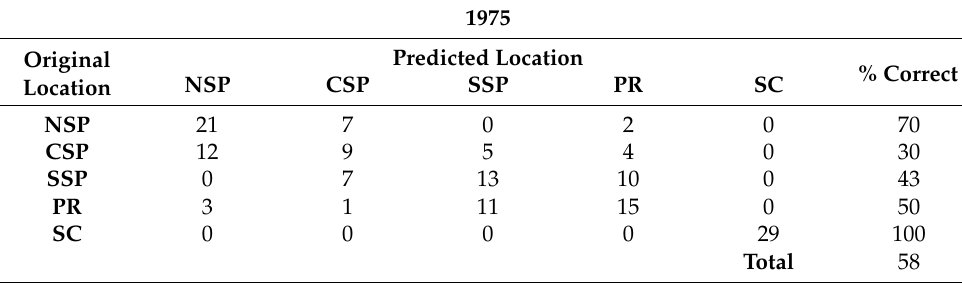
Figure 3. Canonical analysis of principal coordinates (CAP) plots from otoliths chemical composition analysis of Isopisthus parvipinnis collected in the five sampling locations in the South Brazil Bight in 1975 and 2018/2019. Legend: North of São Paulo (NSP), Center of São Paulo (CSP), South of São Paulo (SSP), Paraná (PR), and Santa Catarina (SC). Table 4. Jackknifed cross-validation reclassification matrices obtained from otolith’s elemental composition of Isopisthus parvipinnis from all sampling locations for the years 1975 and 2018/2019. Legend: North of São Paulo (NSP), Center of São Paulo (CSP), South of São Paulo (SSP), Paraná (PR), Santa Catarina (SC).